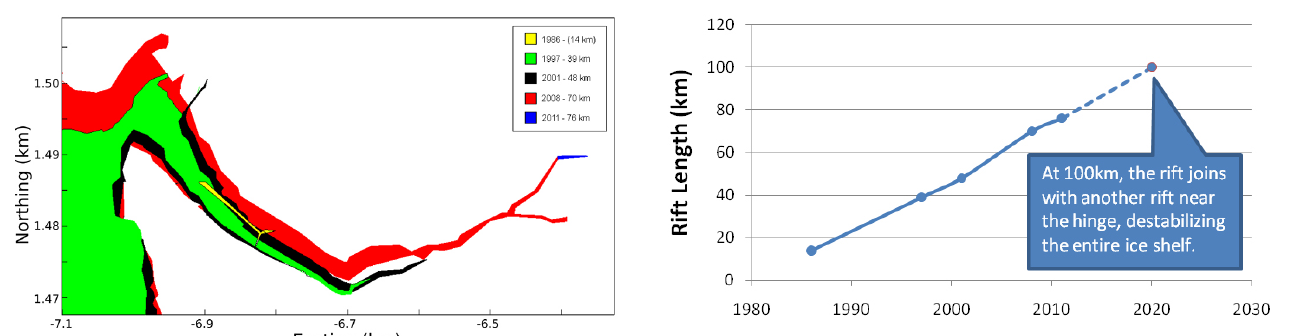
Fig. 10. The Brunt-Stancomb chasm length, extrapolated to the next rift (pictured in Fig.